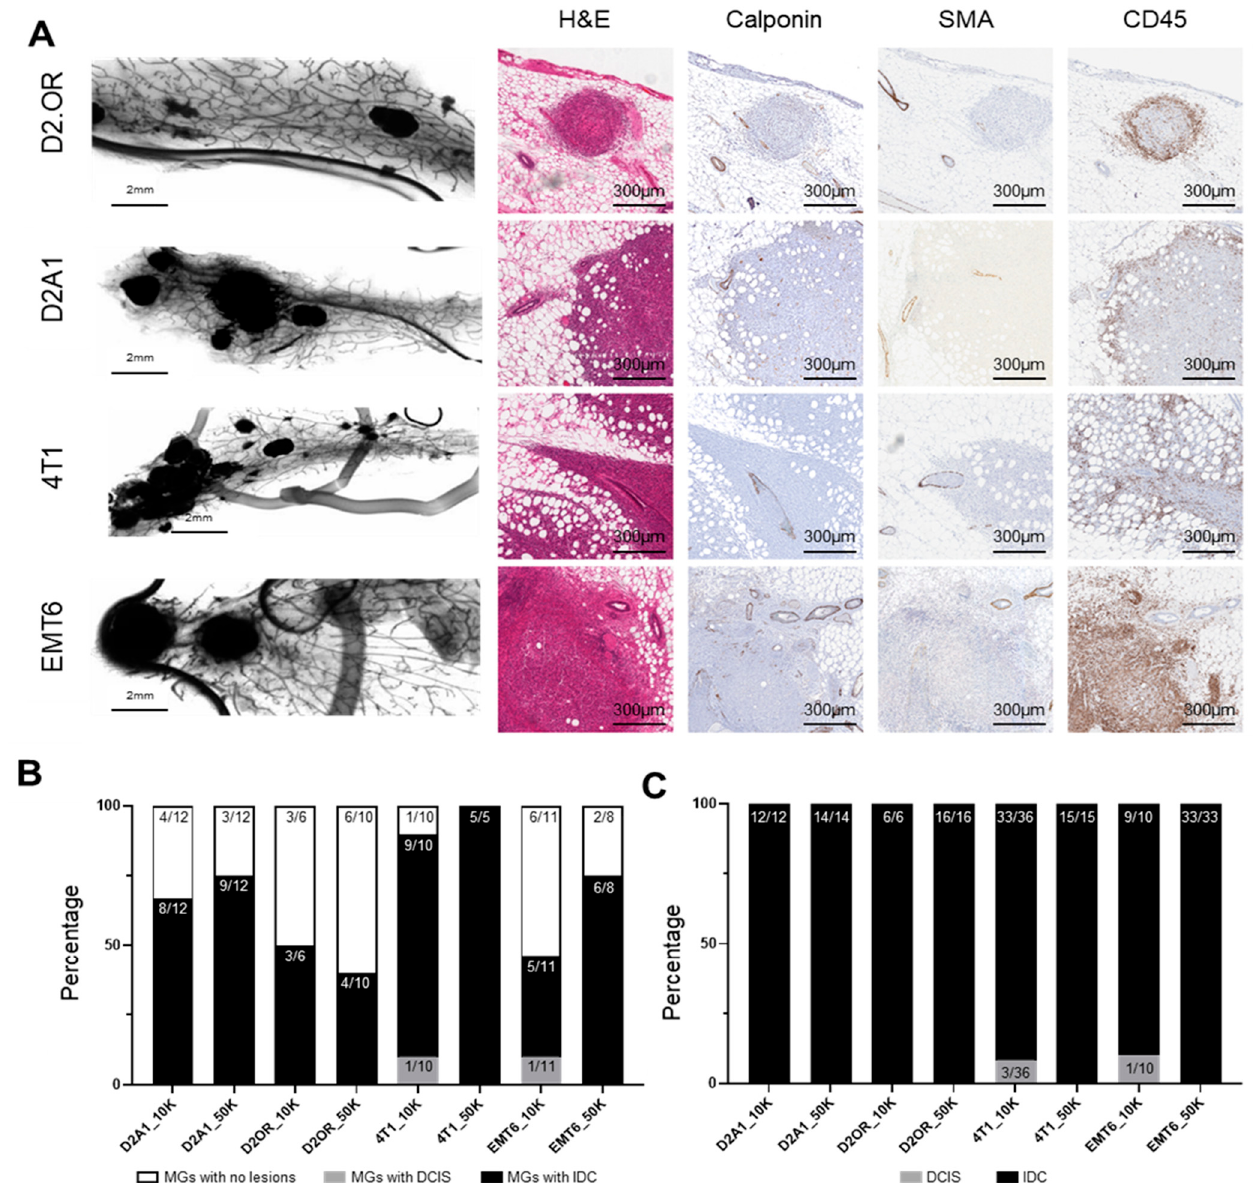
Figure 3. Characterization of tumors derived from intraductal injection of mammary cell lines into BALB/c immune-competent hosts. Murine mammary cell lines D2A1, D2.OR, 4T1, or EMT6 were intraductally injected into the 4th mammary glands of BALB/c mice at either 1 × 10 4 (10K) cells or 5 × 10 4 (50K) cells in 2 µL. Mammary glands were collected when the fi rst tumor became palpable. ( A ) Whole mount and histochemical staining of mammary glands injected with murine mammary cancer cell lines. ( B ) The total number of injected mammary glands that developed tumors. ( C ) The proportion of lesions that were ductal carcinoma in situ (DCIS) or invasive carcinoma (IDC). Abbreviations: MG = Mammary Gland.